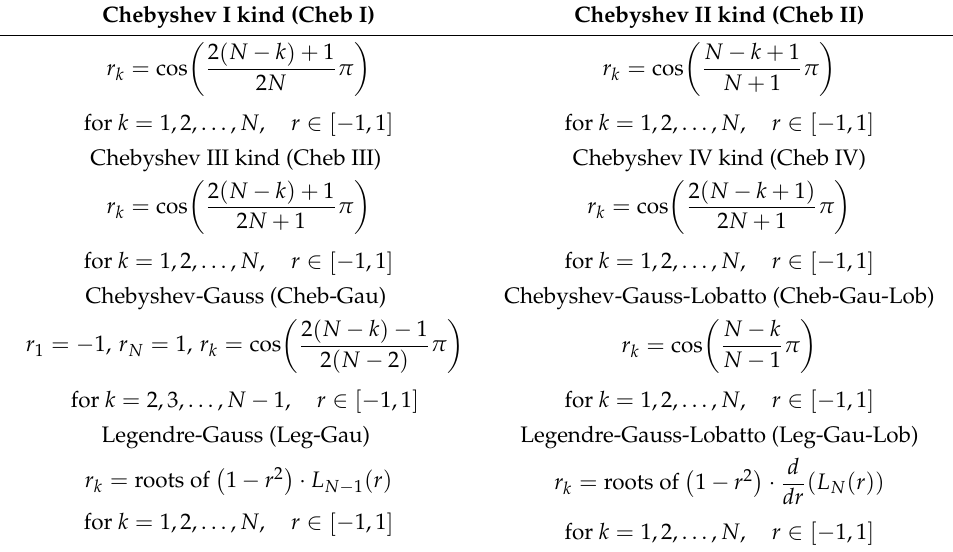
Table 1. Eight different kinds of grid distributions. The indices k and N specify respectively i and I N , when α 1 direction is taken into account. On the other hand, they correspond to j and I M when α 2 direction is considered. Finally, if the grid distribution has to be applied along the coordinate ζ , one gets k = m and N = I T . It should be noted that L N denotes the Legendre